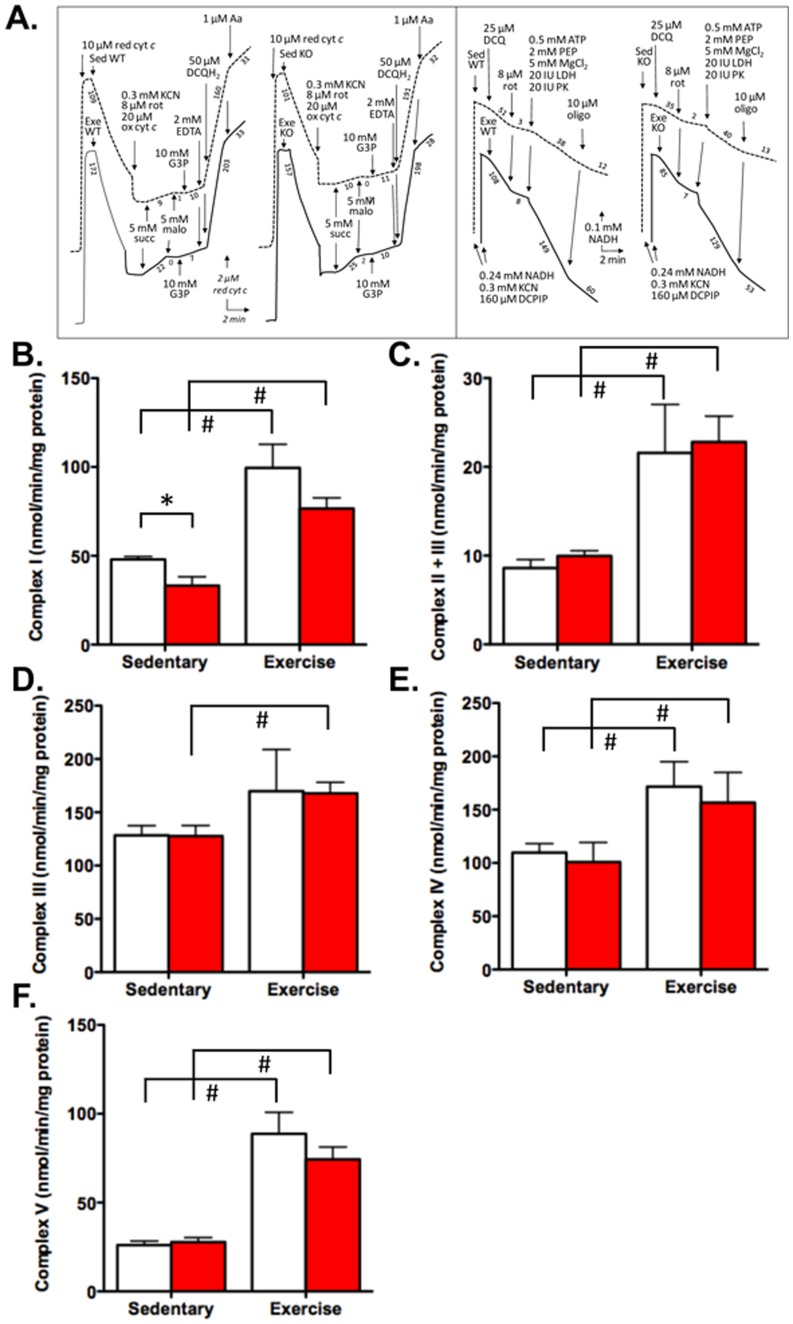
Intact Electron Complex Activity in Myo-PGC-1α in response to exercise.A.) Enzymatic traces of complex activities B.) Rotenone sensitive NADH dehydrogenase activity (Complex I). C.) Succinate-cytochrome creductase activity (Complex II+III). D.) Glycerol-3-phosphate dehydrogenase + Complex III, rate dependent on glycerol-3-phosphate dehydrogenase (Complex III). E.) Cytochrome oxidase activity (Complex IV).F.) ATPase activity (Complex V). Myo-PGC-1αKO (red bar) and littermate controls (white bar). Error bars indicate s.e.m.; n >3 per group in all panels. * - P<0.05 compared to control; # - P<0.05 compared to sedentary.